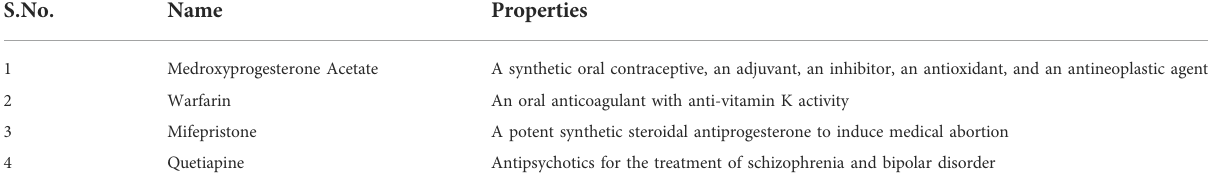
TABLE 1 Representing four drugs and their medicinal use that severely affected larval axon regeneration. S.No.